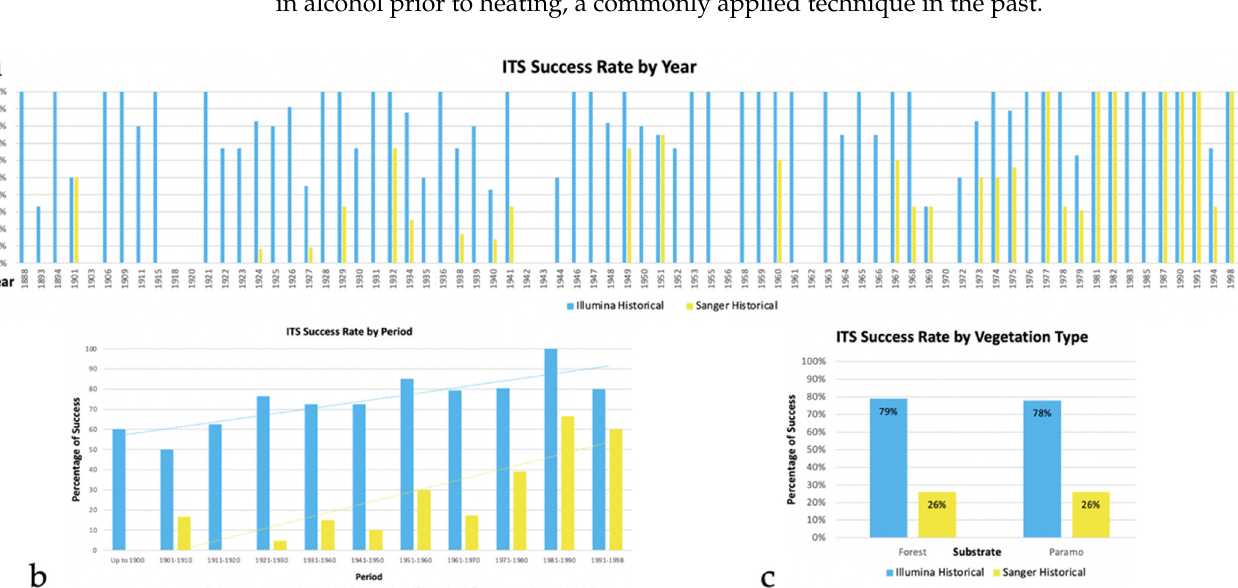
Figure 3. Overall ITS Success Rate in Illumina versus Sanger sequencing with historical and fresh samples ( a ), including a comparison by substrate ( b ). Color pallet proposed by Wong [77].